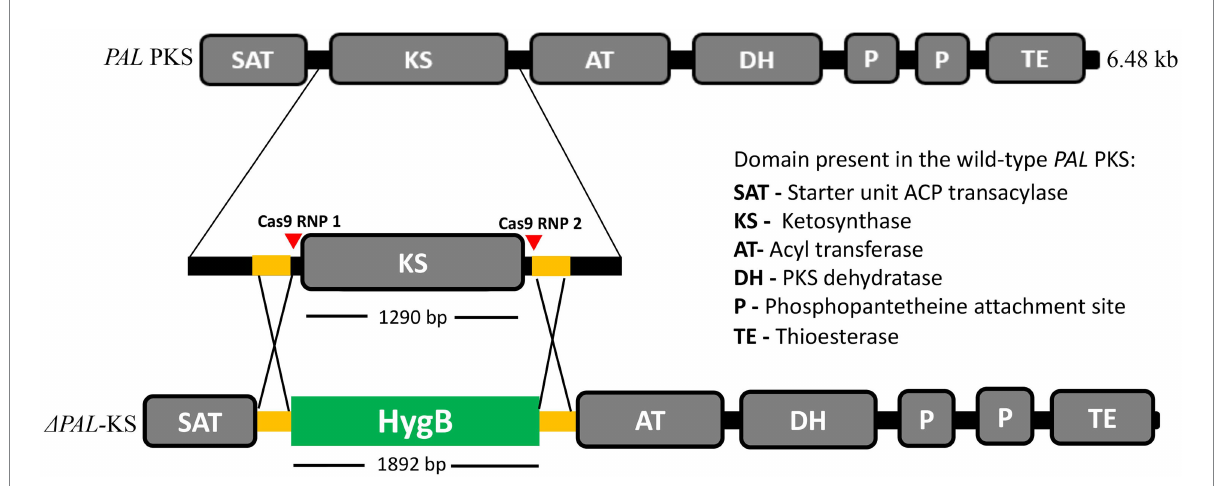
FIGURE 1 Schematic illustration of PAL KS domain deletion strategy by in vitro -assembled dual Cas-9 ribonucleoprotein coupled with homology-directed repair. The red triangles indicate the cleavage sites of the two Cas9-RNPs, while the orange and green segments indicate the 50-bp microhomology regions and the hygromycin B resistance cassette,